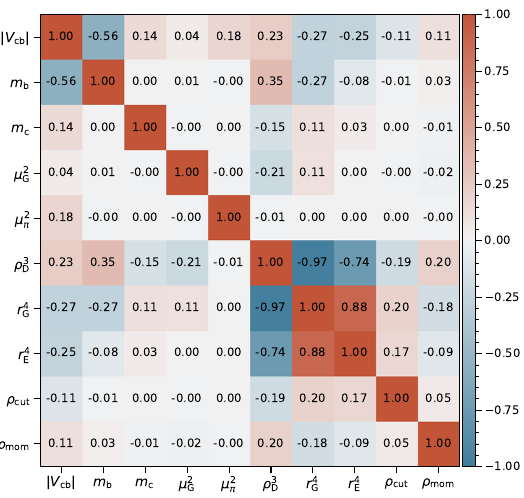
Figure 16 . Correlation matrix for | V cb | , the HQE parameters, and the correlation parameters ρ mom and ρ using Belle data only. cut